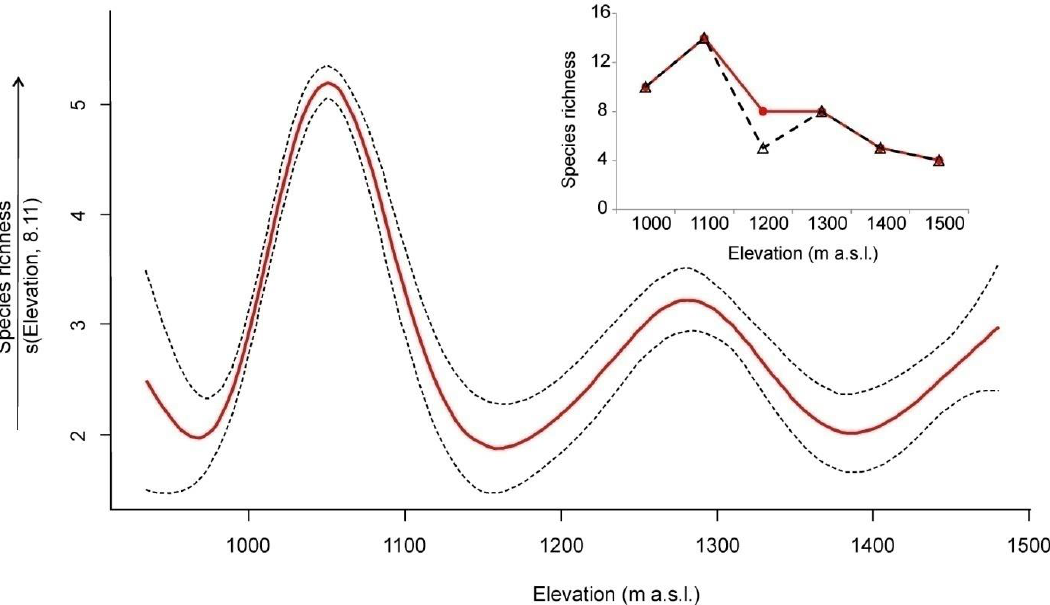
Figure 3. The variability in the species richness of bat assemblages captured in the forest of the Polish Tatra Mountains between 2016 and 2020 as a function of elevation (GAM: species richness, intercept+s(elevation)). In the inner subplot, empirical (dashed black line and empty black triangles; number of recorded species on every 100 m vertical band) and interpolated (solid red line and red circles; species were recorded in a range between the highest and the lowest records) species richness are